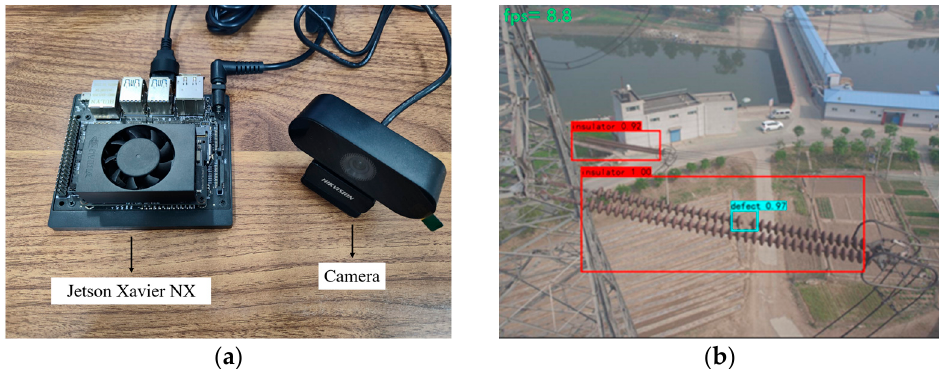
Figure 13. Embedded devices and deployment results: ( a ) the embedded device unit; ( b ) the effect of edge-end device operation.